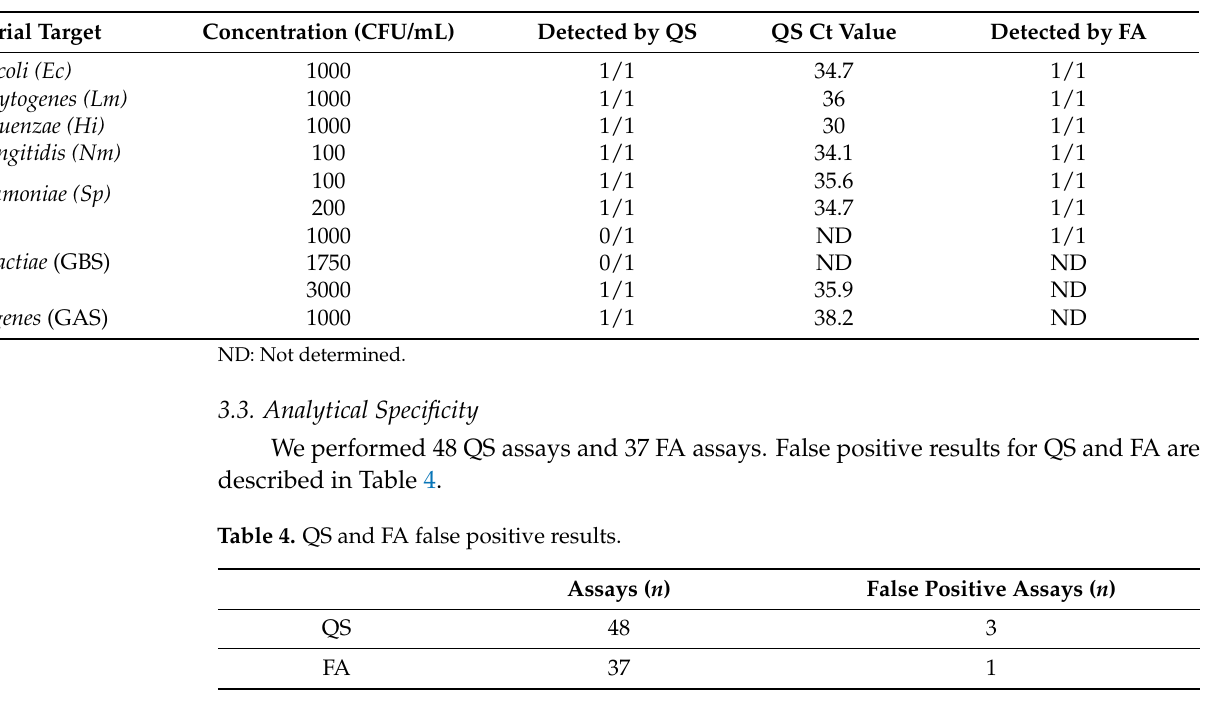
Table 3. Results of the detection of low bacterial concentrations with QS and FA.